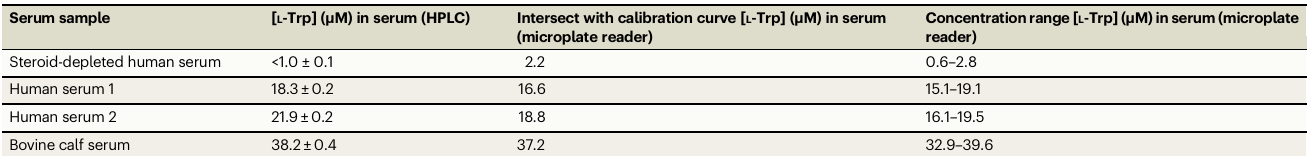
Table 3 | Trp concentrations of different blood sera were determined via HPLC (estimated error of 10% based on deviations within the repetitions) and emission-based microplate reader measurements of rotaxane 1 at 25 °C Serum sample